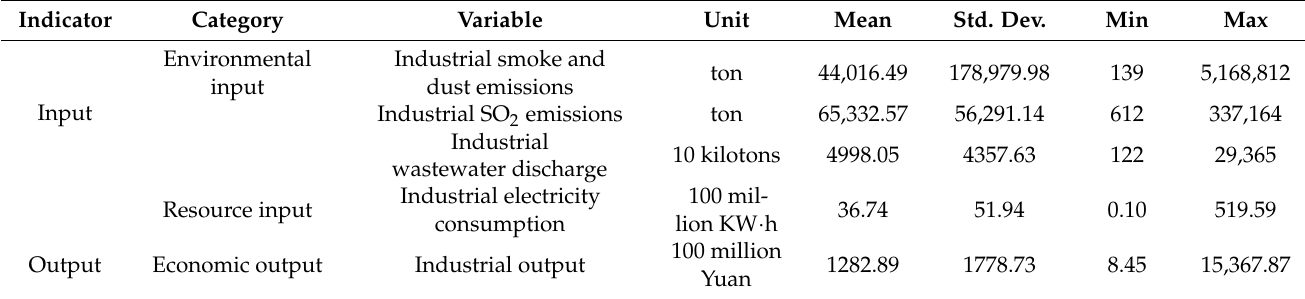
Table 1. Descriptive statistics of input and output